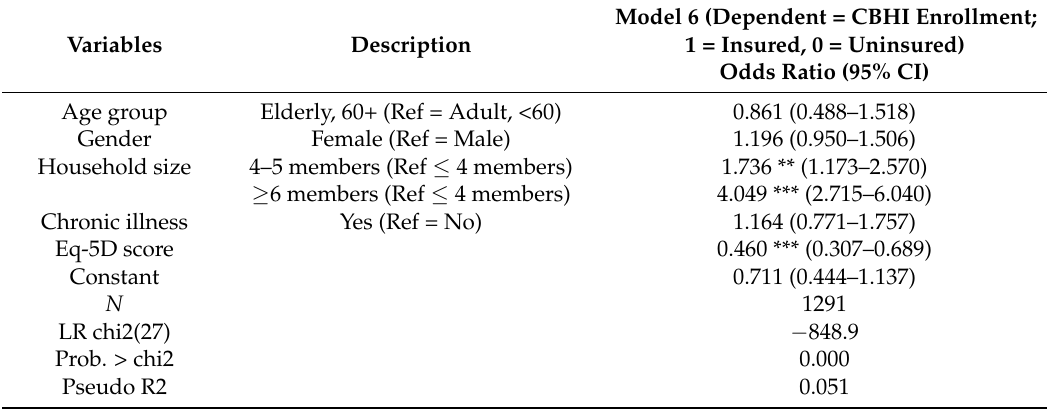
Table 5. Association between EQ-5D score and CBHI